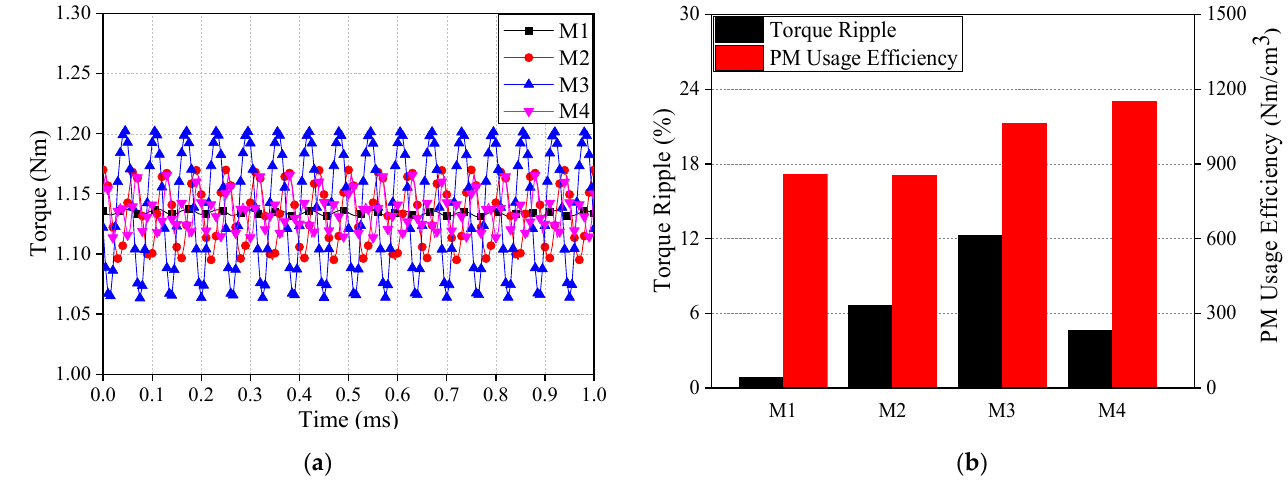
Figure 3. HSPMSM torque with different rotors at no-load. ( a ) Waveforms; ( b ) spectral